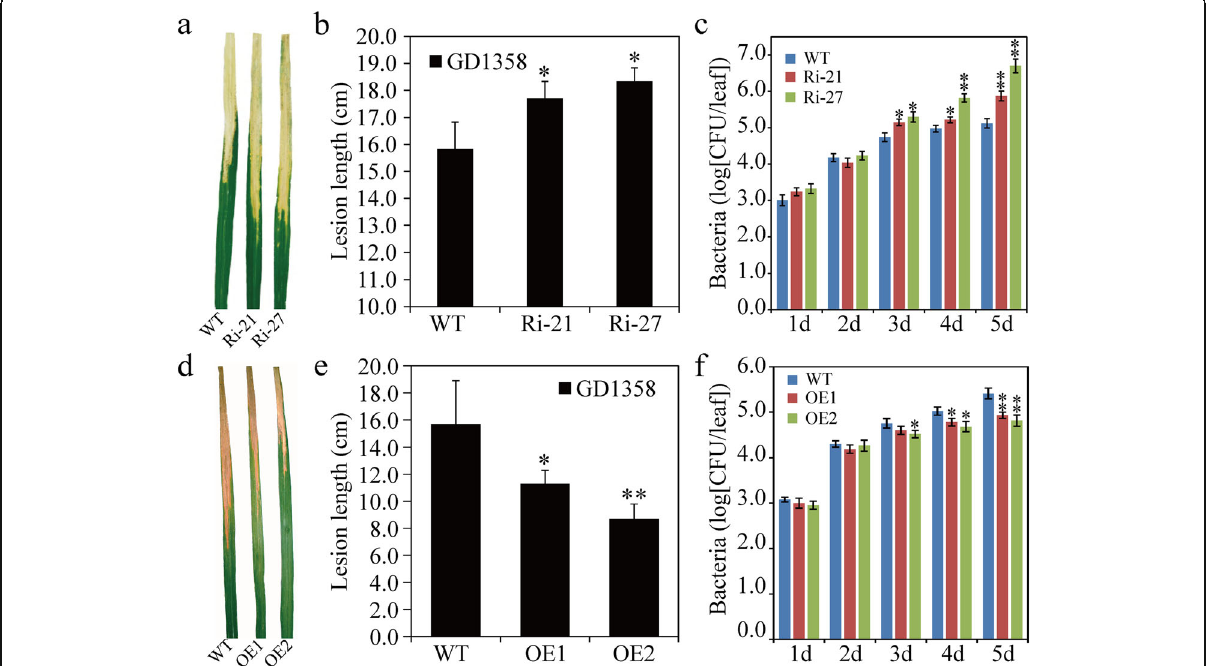
Fig. 2 Phenotypic responses of OsSAPK9-RNAi , OsSAPK9 - overexpression ( OsSAPK9-OE ), and wild-type (WT) plants to infection by Xanthomonas oryzae pv. oryzae ( Xoo ) strain GD1358. a Phenotypes of OsSAPK9-RNAi and WT plants infected with Xoo strain GD1358. Photographs were taken 12 d after inoculation. b Lesion lengths of bacterial blight in the OsSAPK9-RNAi and WT plants 12 d after inoculation with Xoo strain GD1358. c Growth curves of the Xoo strain GD1358 in OsSAPK9-RNAi and WT plants. CFU, colony-forming units. d Phenotypes of OsSAPK9-OE and WT plants infected with Xoo strain GD1358. Photographs were taken 12 d after inoculation. e Lesion lengths of bacterial blight in the OsSAPK9-OE and WT plants 12 d after inoculation with Xoo strain GD1358. f Growth curves of Xoo strain GD1358 in OsSAPK9-OE and WT plants. CFU, colony-forming units. Values are presented as the means and standard errors of three replicates. * P < 0.05, according to a Student ’ s t